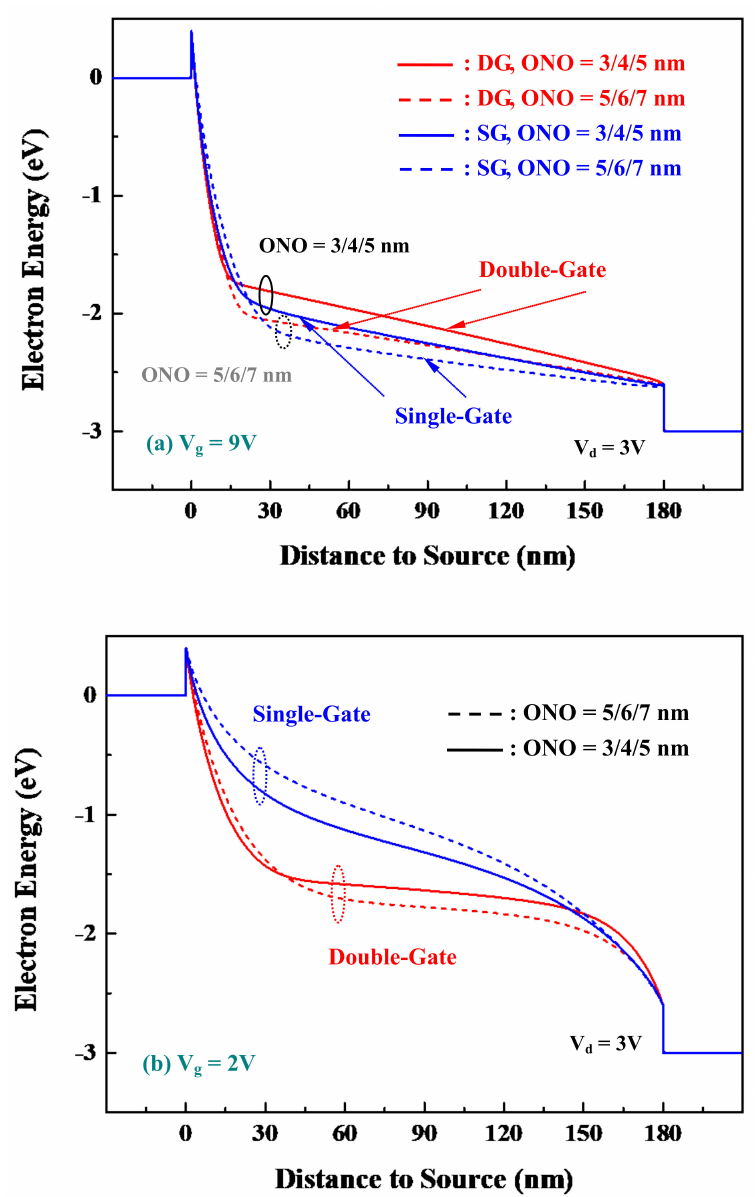
Figure 5. Conduction band diagrams of single- and double-gate Schottky barrier charge-trapping cells along the channel surface at gate voltages of ( a ) V g = 9 V and ( b ) V g = 2